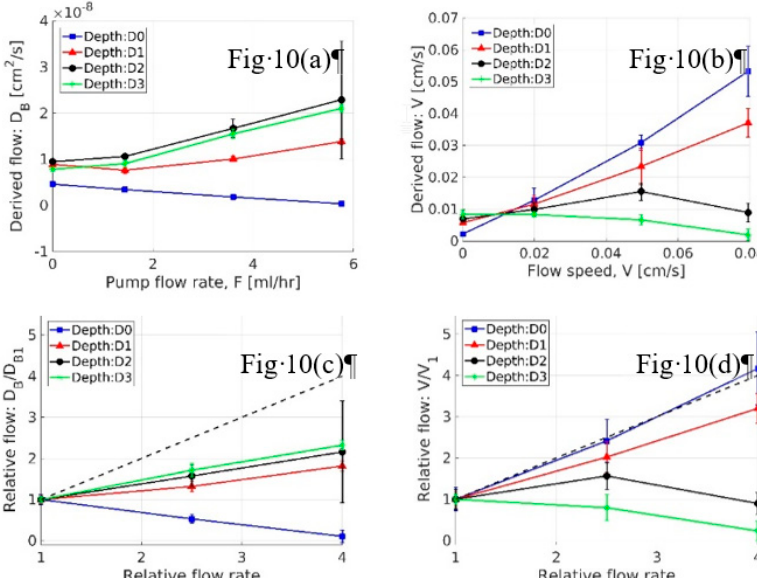
Figure 10. Derived flow coefficients obtained from fitting phantom data using Equation (2). ( a , b ) show the retrieved Brownian di ff usion D B and flow speed V , for each phantom. Each line shows fixed channel depth (shown in legend), symbols show mean values and error bars are standard deviations (across the five DCS scans obtained for each phantom). ( c , d ) show relative changes flow vs. relative change in input flow rates, normalized relative to flow phantoms F 1 . Dashed line in ( c , d ) show y = x .